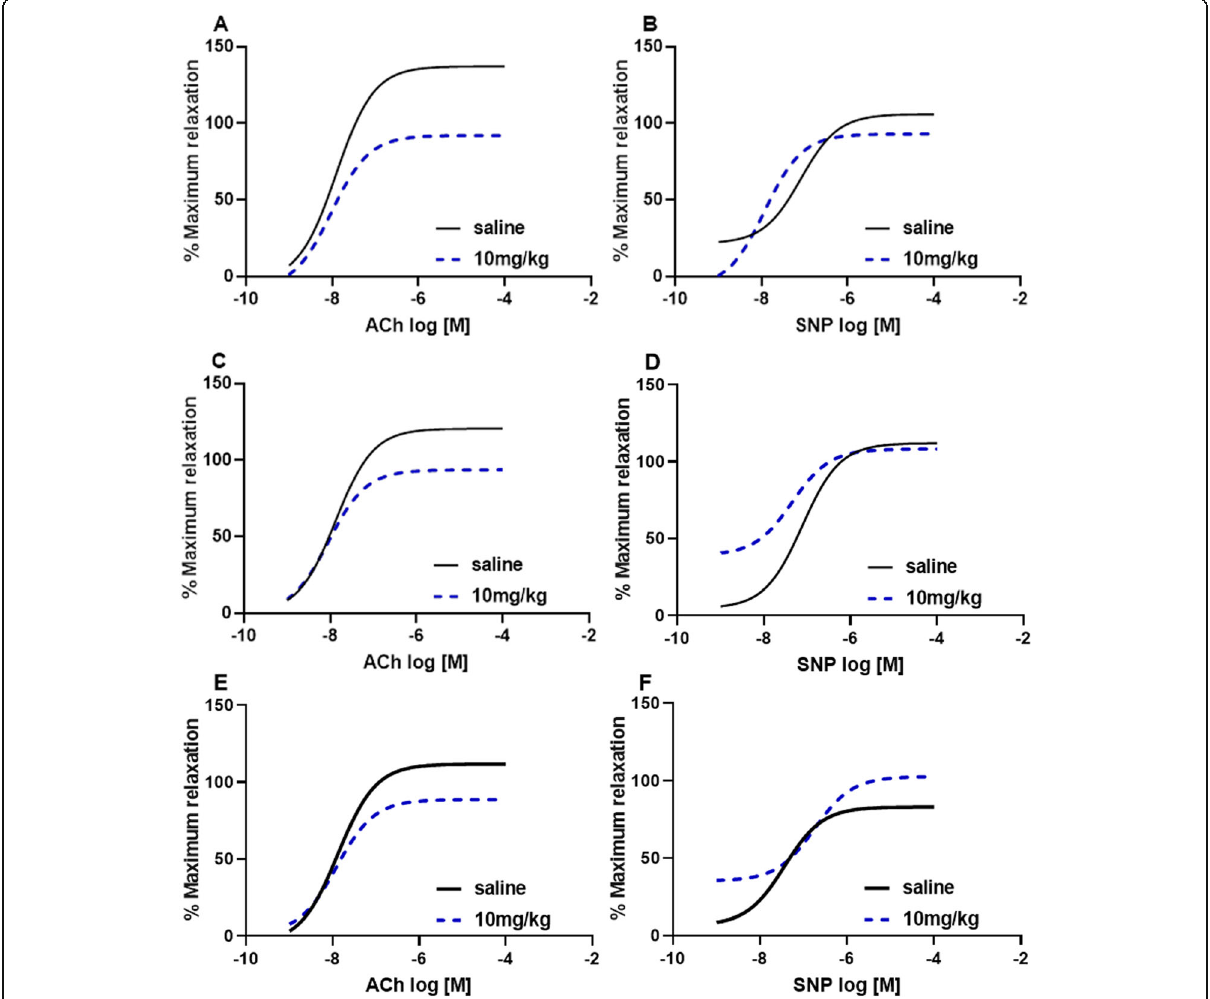
Fig. 5 Vascular relaxation responses in isolated aortic rat rings exposed to 0 and 10 mg/kg of LPS (treatments A and D). Left side: change in vascular endothelium-dependent relaxation response to acetylcholine (ACh) rats. Right side panel: endothelium-independent relaxation response to nitric oxide donor sodium nitroprusside (SNP). a and b : underweight rats, c and d : normal weight rats, e and f : overweight